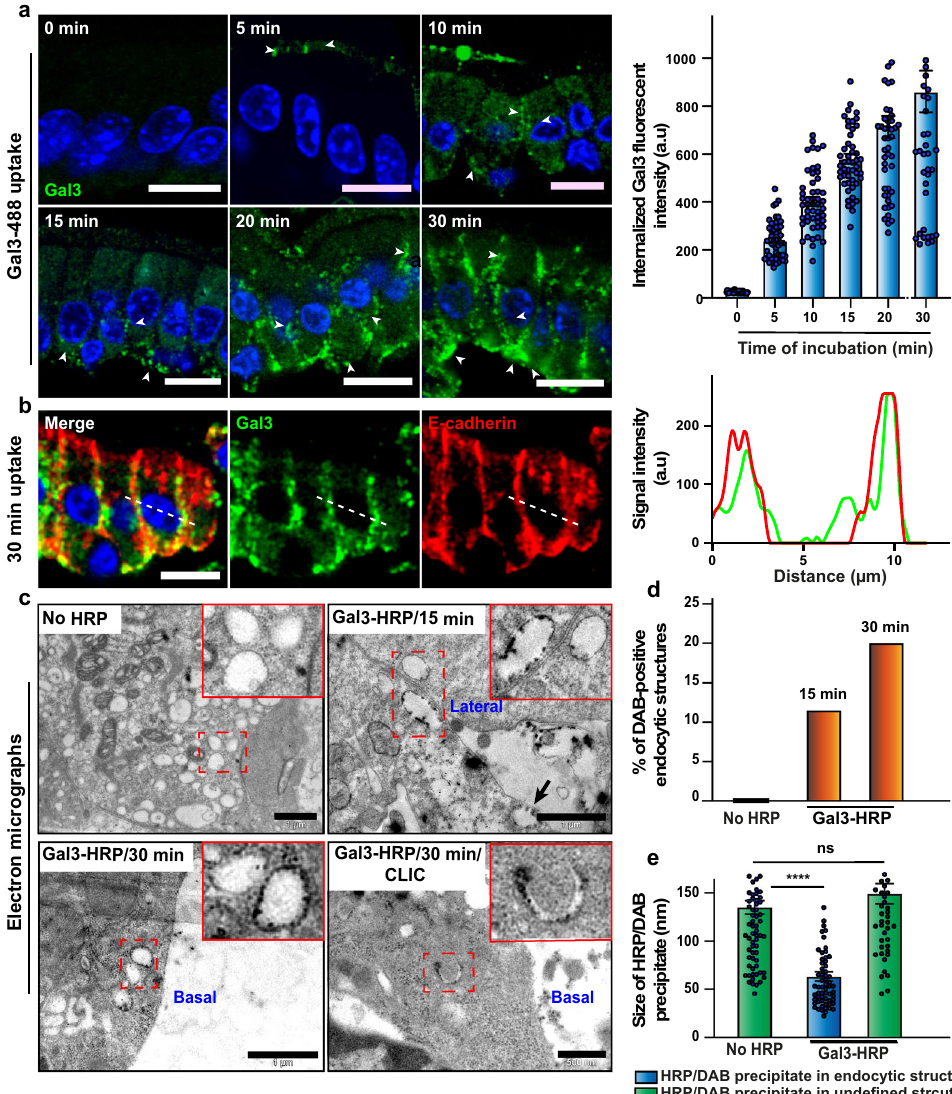
Fig. 3 Internalization of exogenous Gal3 into enterocytes. a Pulse-chase experiment of Gal3 uptake in enterocytes. Gal3 (green) was bound at 4 °C to enterocytes of DTT-treated jejunum. After washing, incubations were performed at 37 °C for the indicated periods of time. Cell surface-exposed Gal3 was removed with lactose wash. Note that no signal is detected when cells were not incubated at 37 °C (0 min). However, when shifted to 37 °C, distinct intracellular structures become visible as early as after 5 min of incubation (arrowheads). The fl uorescence signal of internalized Gal3 is shown to the right in function of time (means ± SEM, n = 50 cells quanti fi ed per condition, one representative of three independent experiments). Nuclei in blue. Scale bars = 10 µ m. b Apically internalized Gal3 accumulates at the basolateral membrane. Enterocytes were continuously incubated for 30 min at 37 °C with apically added Gal3 (green). Cell surface-exposed Gal3 was removed by lactose wash. Cells were labeled for the adherens junction marker E-cadherin, which is known to be localized to the basolateral membrane. A clear overlap between Gal3 and E-cadherin (RGB plot) indicates that Gal3 is indeed transcytosed in these enterocytes. Nuclei in blue. Scale bars = 10 µ m. c Electron microscopy analysis of Gal3 uptake into enterocytes of the DTT-treated jejunum. After 15 min of incubation at 37 °C with 40 μ g/mL of HRP-coupled Gal3, electron-dense DAB precipitates (arrowheads) are found in vacuolar structures close to the lateral membrane (Gal3-HRP/15 min micrograph) and mainly accumulate at the basal side after 30 min of incubation (Gal3-HRP/30 min micrograph). Some tubular crescent-shaped structures could be detected with typical CLIC morphology (Gal3-HRP/30 min/CLIC micrograph). For comparison, a cell that was incubated in the absence of Gal3-HRP is shown in the No HRP micrograph. Red-dashed insets represent endocytic structures. Scale bars = 500 nm for the bottom-right electron microscopy image and 1 µ m for the others. d Endocytic structures containing electron-dense DAB precipitate were quanti fi ed in the indicated conditions. Percentage of DAB-positive endocytic structures (no HRP condition, n = 525 endocytic carriers; Gal3-HRP/15 min condition, n = 224 endocytic carriers; Gal3-HRP/30 min condition, n = 131 endocytic carriers were analyzed). e Two types of precipitates were detected, of which only the smaller one was speci fi c for the Gal3-HRP condition. Quanti fi cation of the size of dark precipitates (means ± SEM; no HRP condition, n = 79 precipitates were measured within unde fi ned structures; Gal3-HRP condition, n = 62 precipitates were measured within endocytic structures, and n = 49 precipitates in unde fi ned structures). Ordinary one-way ANOVA, ∗∗∗∗ P < 0.0001, ns non-signi fi